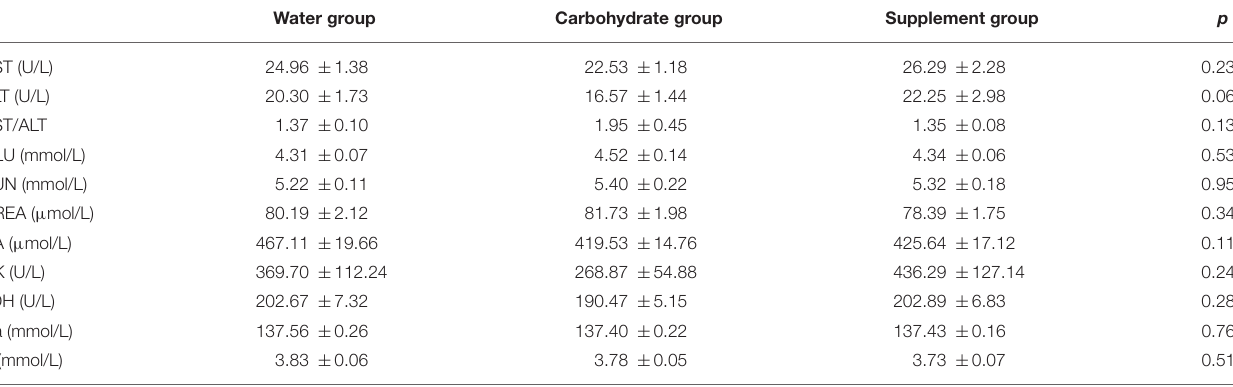
TABLE 3 | Biochemical parameters of participants in short-term supplement trial at baseline.